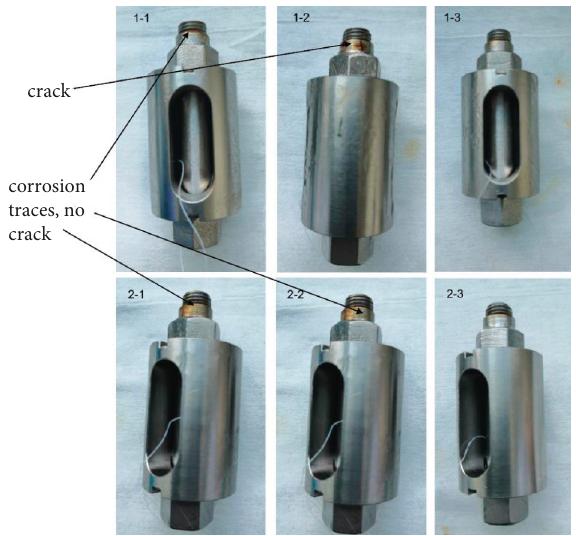
Figure 11: The surface condition of the test piece soaked in boiling magnesium chloride solution for